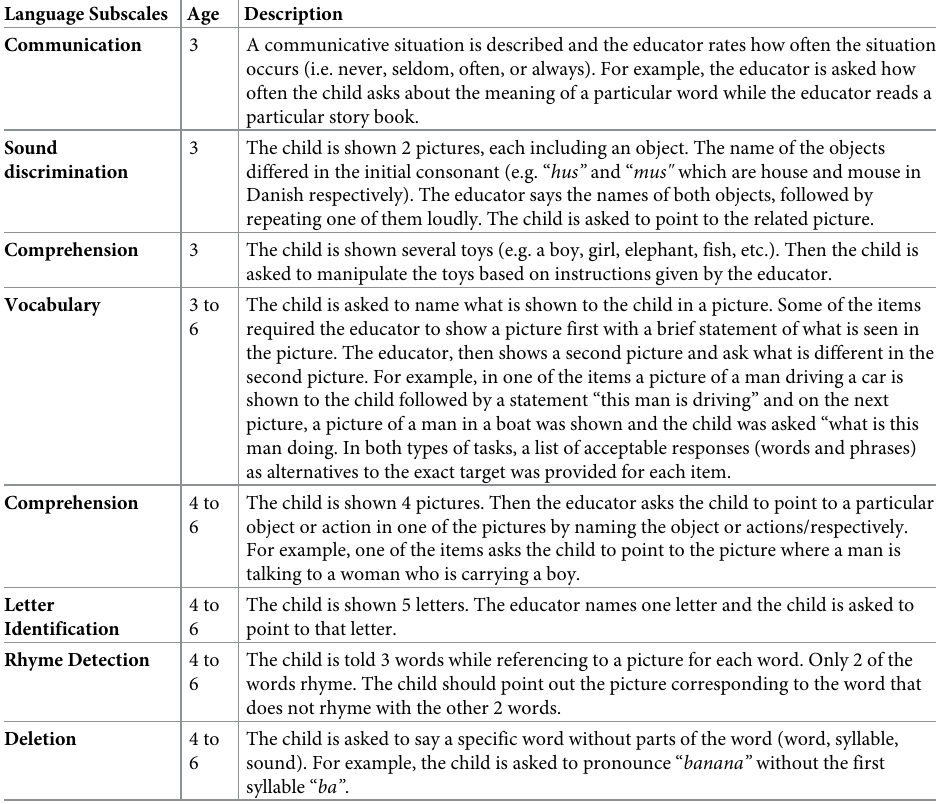
Table 2. Description of the tasks involved in subscales of the language assessment instrument.